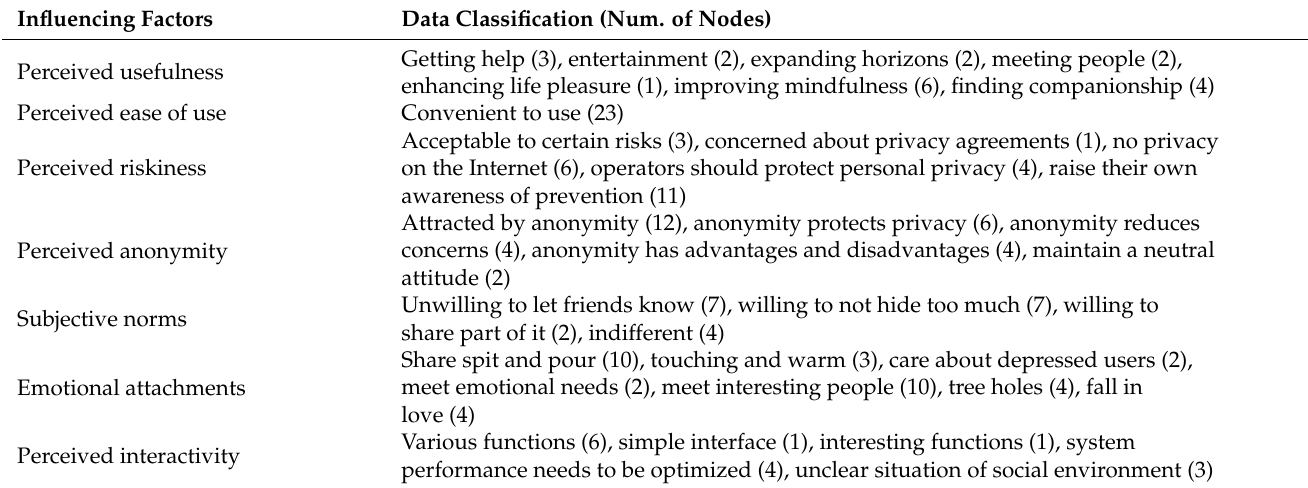
Table 4. The reasons and purposes of usage intention. Data Classification (Num. of